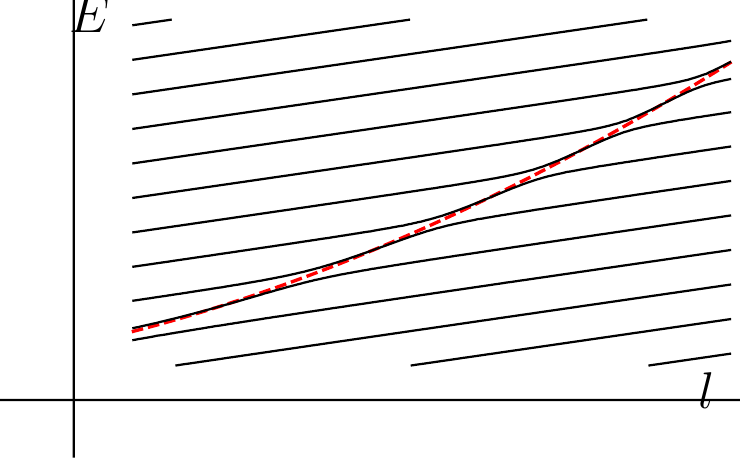
Figure 5 . Regge trajectories of scattering states in the presence of a resonance. The dashed red curve shows the energy E R ( l ) of the resonance. Far from the resonance we have evenly-spaced Regge trajectories, determined by the ‘background’ phase shift ¯ δ l ( E ) . There is an additional physical state with energy close to the resonance. Where the resonance crosses a ‘background’ Regge trajectory, the trajectories reconnect to avoid intersecting. Close to such a reconnection (when E R is close to a ¯ δ ) ), for narrow resonances Γ (cid:28) ω the background Regge trajectory of energy ¯ E = ω ( d + l + 2 n + 2 2 π Regge trajectories are determined by the solutions to ( E − ¯ E )( E − E R ) = ω Γ . These reconnections π are the result of strong mixing between the resonance and the background scattering state when √ | E R − ¯ E | . ω